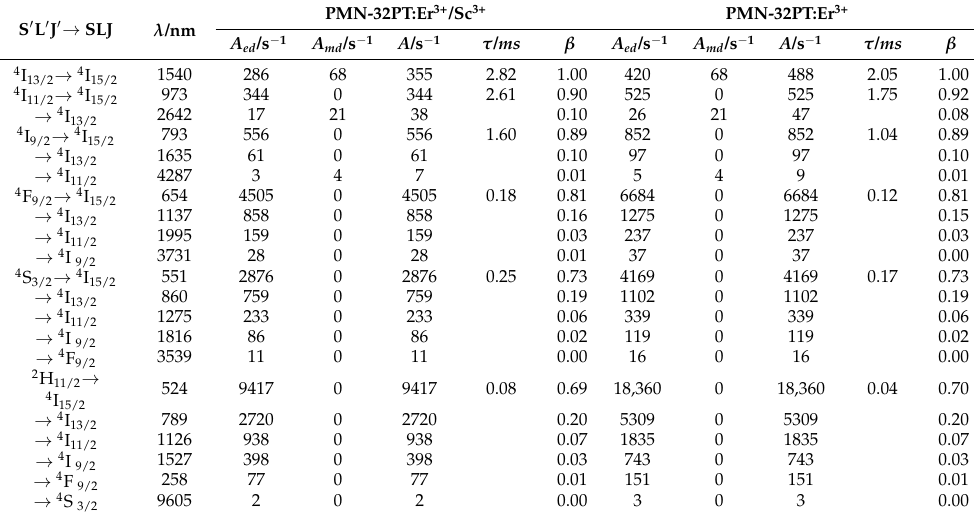
Table 5. Spectroscopic parameters of Er 3+ in PMN-32PTcrystal.